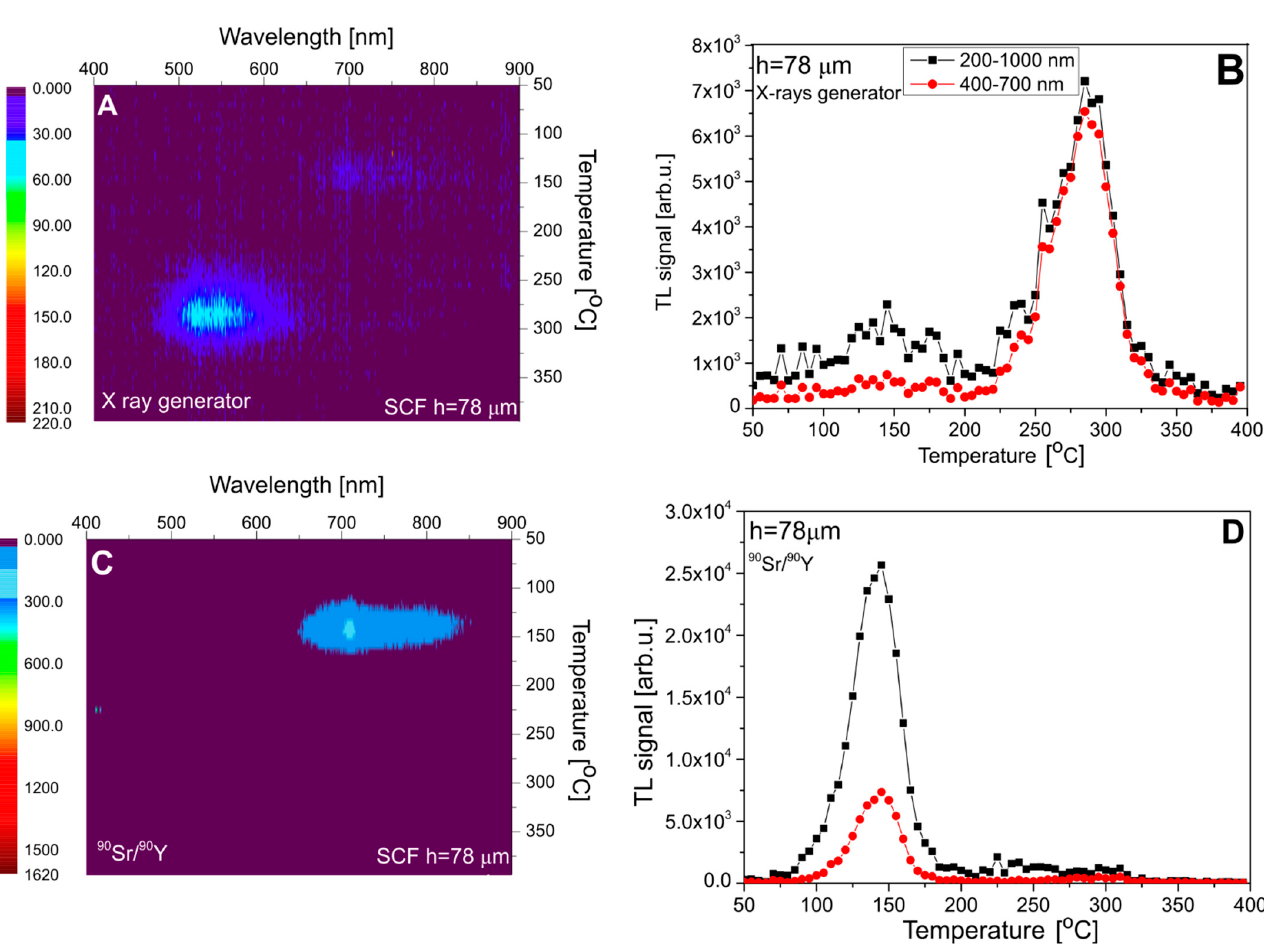
Figure 9. The emission spectra of sample #3 ( panel A —after irradiation with 15 kV X-rays) and panel C —after irradiation with 90Sr/90Y) and TL glow curves ( panels B , D ). TL glow curves are taken from the spectral measurements. Table 3. Peak parameter estimations using TL glow